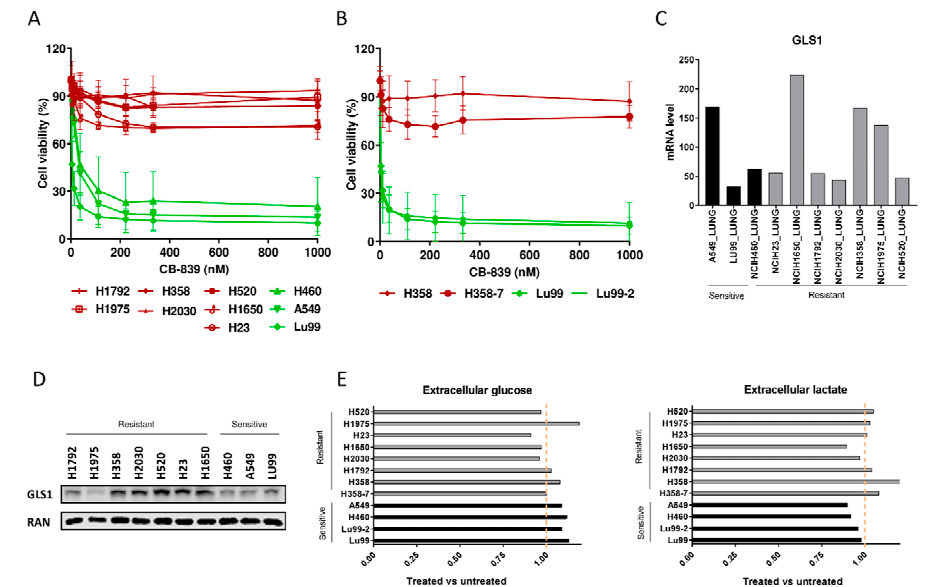
Figure 1. A . Dose–response curves of the NSCLC cell lines panel treated with increasing concentrations of CB-839. The response to the drug was assessed 72 h from the start of treatment with the MTS assay. The average of three independent experiments is reported. B . Dose–response curves of the NSCLC LU99 and H358 LKB1 isogenic systems treated with increasing concentrations of CB-839. The response to the drug was assessed 72 h from the start of treatment with the MTS assay. The average of three independent experiments is reported. C . GLS1 RNAseq gene expression data retrieved from the CCLE [17], in ten NSCLC cell lines. D . Western Blot analysis of GLS1 protein levels in the ten NSCLC cell lines used. Ran was used as loading control. The figure is representative of at least three independent experiments. E . Fold change in abundance (normalized peak area) of